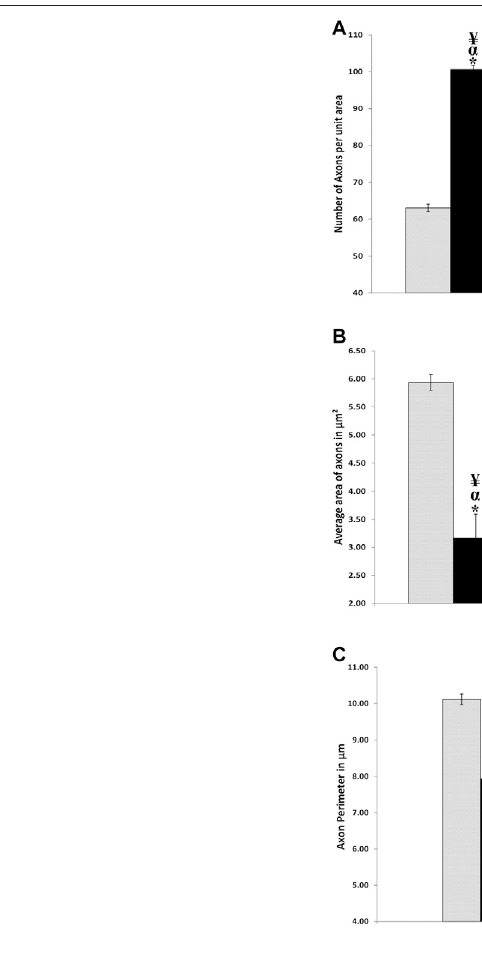
Frontiers in Pharmacology |